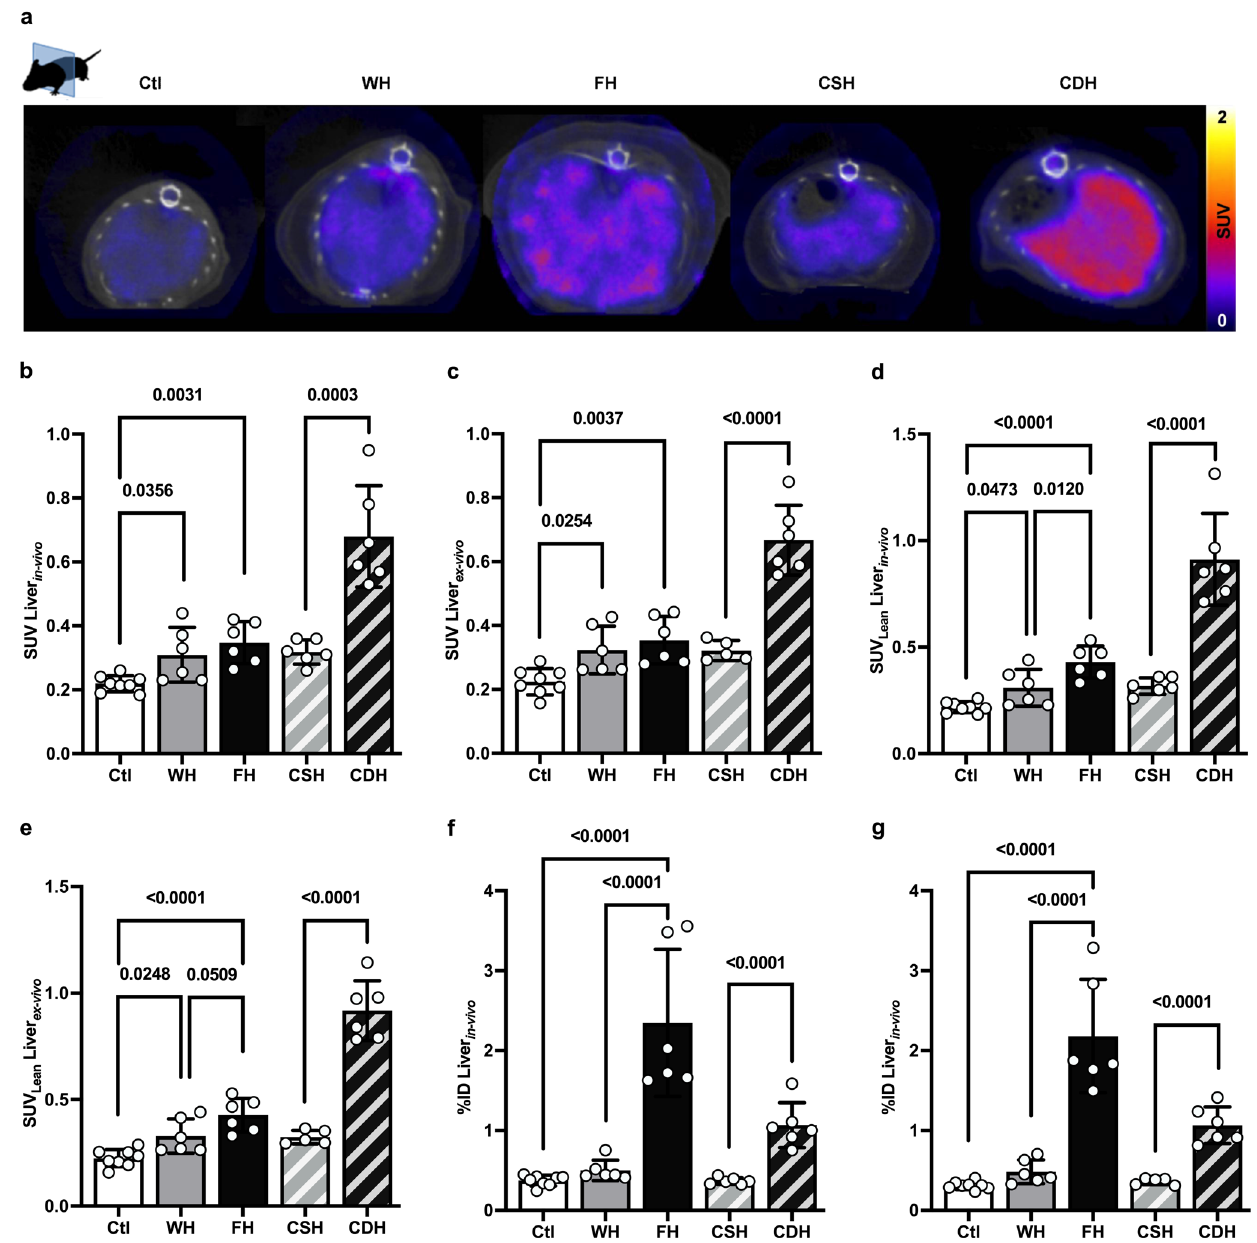
Fig.5| 99m Tc-cAbVCAM1-5liveruptakecorrelateswithVCAM-1expression. SUV Liver measured in all groups a in vivo by SPECT or b ex vivo (one-way ANOVA and Student ’ s t-test, n =8 for Ctl and n =6 for other groups). c Representative SPECT transversalimages.SUV Lean Liver d invivoand e exvivo,andtotalliveruptake(%ID) f invivoand g exvivoof 99m Tc-cAbVCAM1-5evaluatedwithSPECT(one-wayANOVA